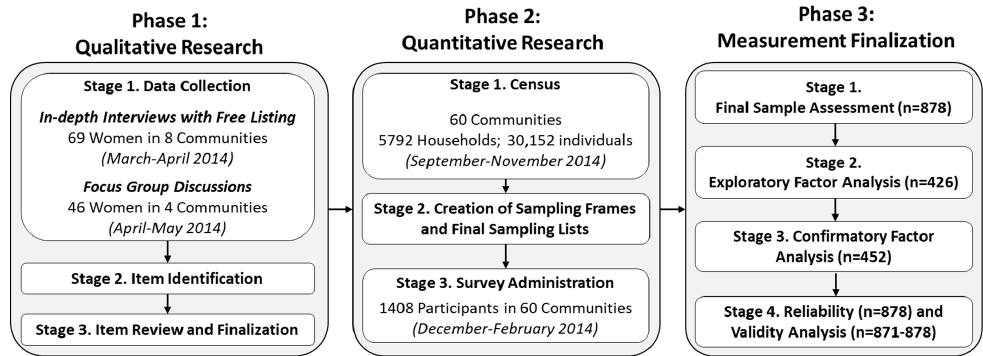
Figure 1. Schematic of Exploratory Sequential Mixed Methods Design Used to Create Menstrual Insecurity Measure.